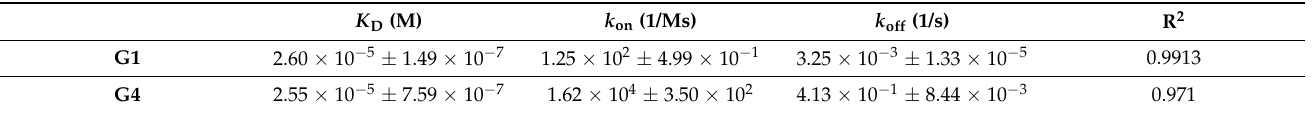
Figure 4. Bio-layer interferometry analysis of G1 and G4 with M pro . ( A ) Association and dissociation data of G1 with M pro . ( B ) Association and dissociation data of G4 with M pro . Table 1. Bio-layer interferometry analysis data of G1 /M pro and G4 /M pro . K D = k off / k on ; k on — association constant; k off — dissociation constant; R 2 — coefficient of determination.